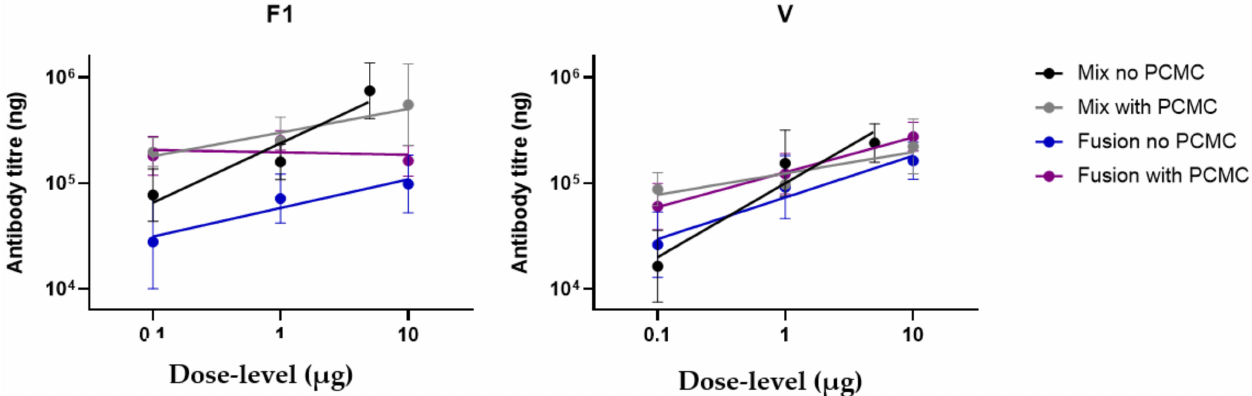
Figure 4. The antibody titres specific to antigen F1 (left) and V (right) of mice immunised against Y. pestis . The immunisations varied in three different ways: the dose level delivered ( x -axis), formulation (with alhydrogel or with PCMC) and vaccine type (a mixture of F1 and V or a